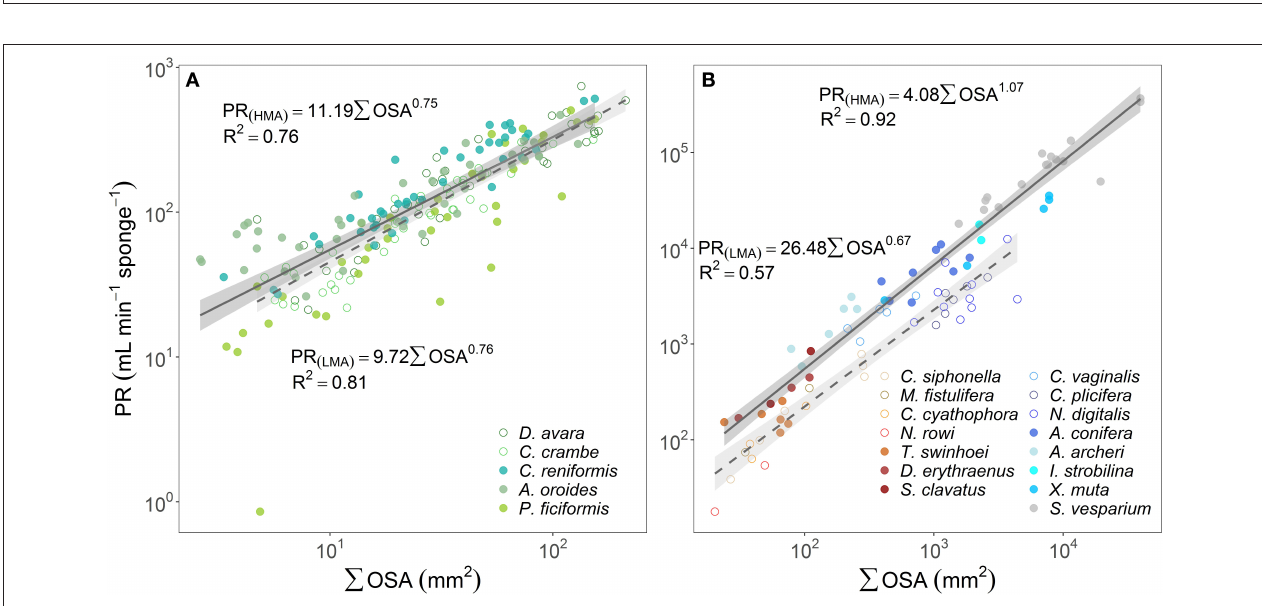
FIGURE 2 | Allometric relationship ( OFR = aOSA b ) between osculum flow rate (OFR, mL min − 1 ) and osculum cross-sectional area (OSA, mm 2 ) for: (A) temperate species from the Mediterranean Sea (5 species), and (B) tropical species from Red Sea (7 species, redish color shades) and Caribbean Sea (8 species, blue color shades). Note that all Caribbean species have a single osculum. The allometric equations are shown in each panel and the shade areas represent the 95% confidence interval for the regression line. The b scaling exponents were statistically different from zero for all equations ( p < 0.001). Note the log-log scale.